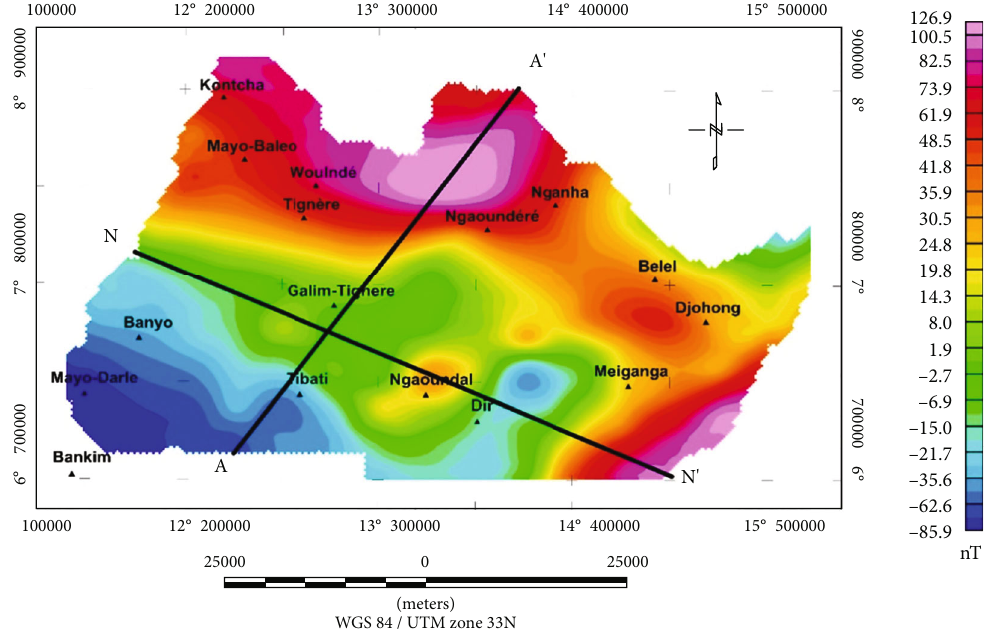
Figure 3: Reduced magnetic map at equator (RTE) illustrating location of 2D magnetic modeling pro fi les.